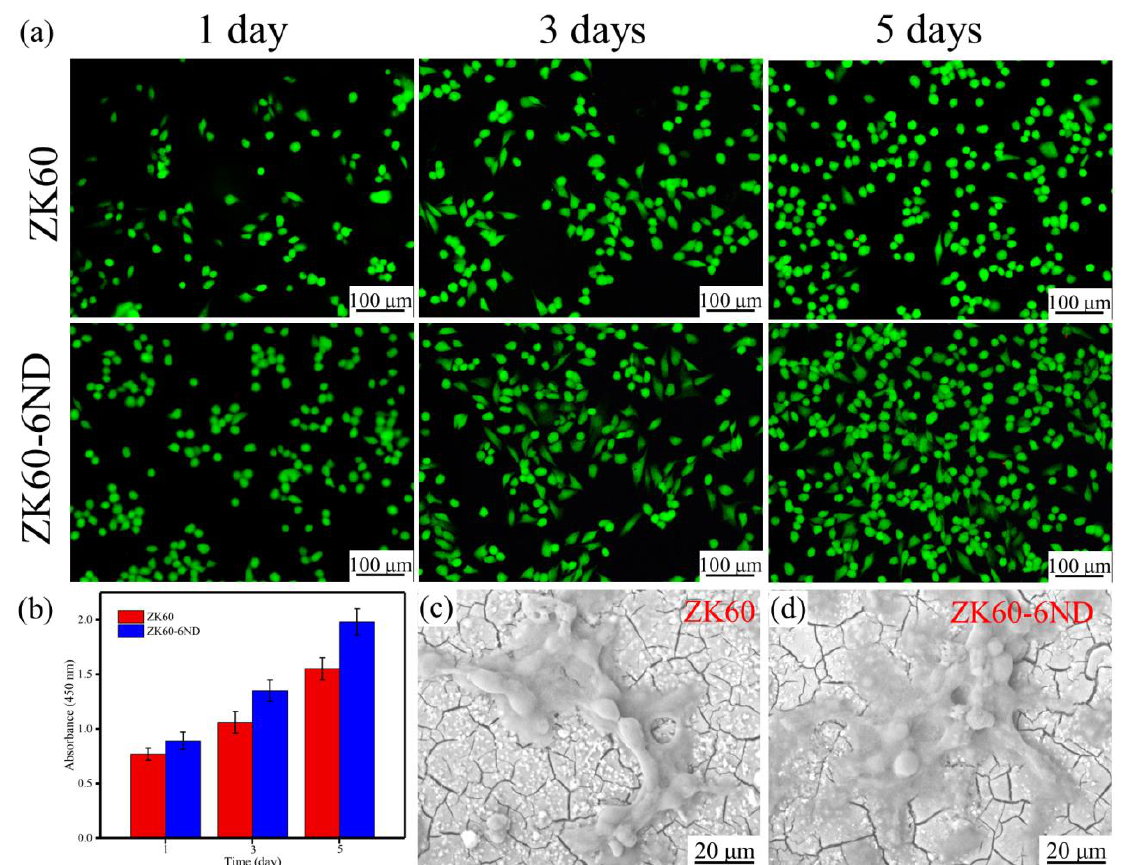
Figure 9. ( a ) Fluorescent images of MG-63 cells cultured in extracts for 1, 3, and 5 days; ( b ) CCK-8 results in extracts for 1, 3, and 5 days; morphologies of MG-63 cells cultured on ( c ) SLMed ZK60 and ( d ) SLMed ZK60-6ND.